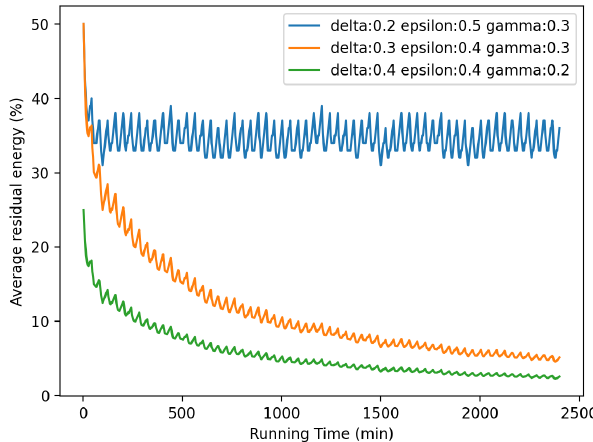
Figure 10. Memory adjustment factor optimizing curve.